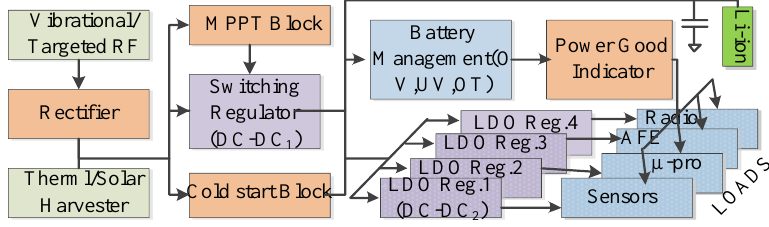
Figure 11. Typical power management architecture in IoT.